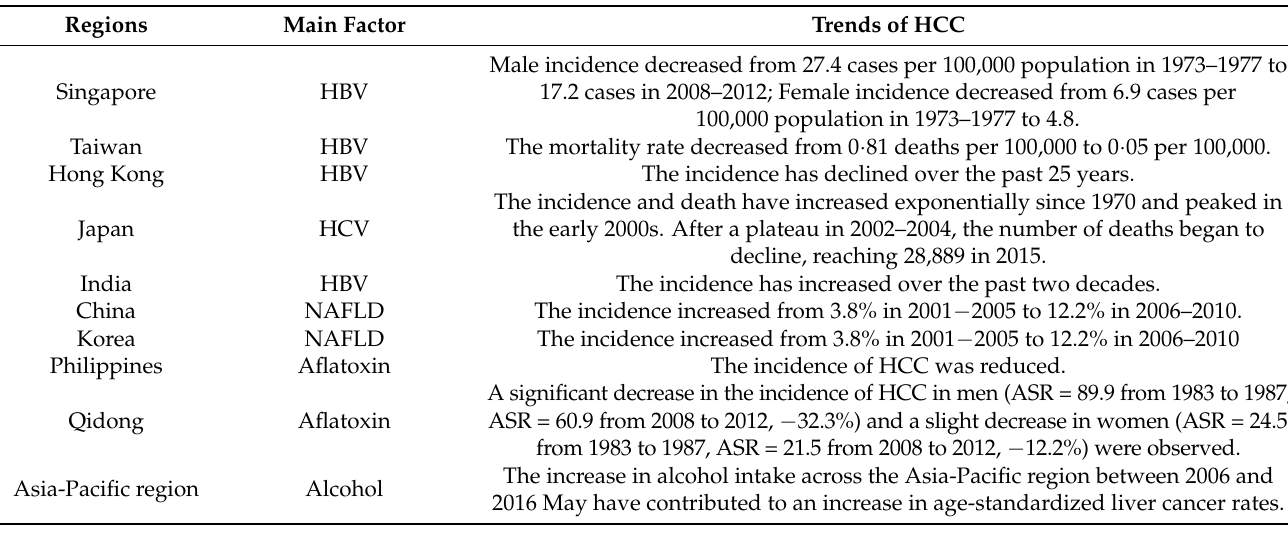
Table 2. The changing epidemiology of HCC in Asia.